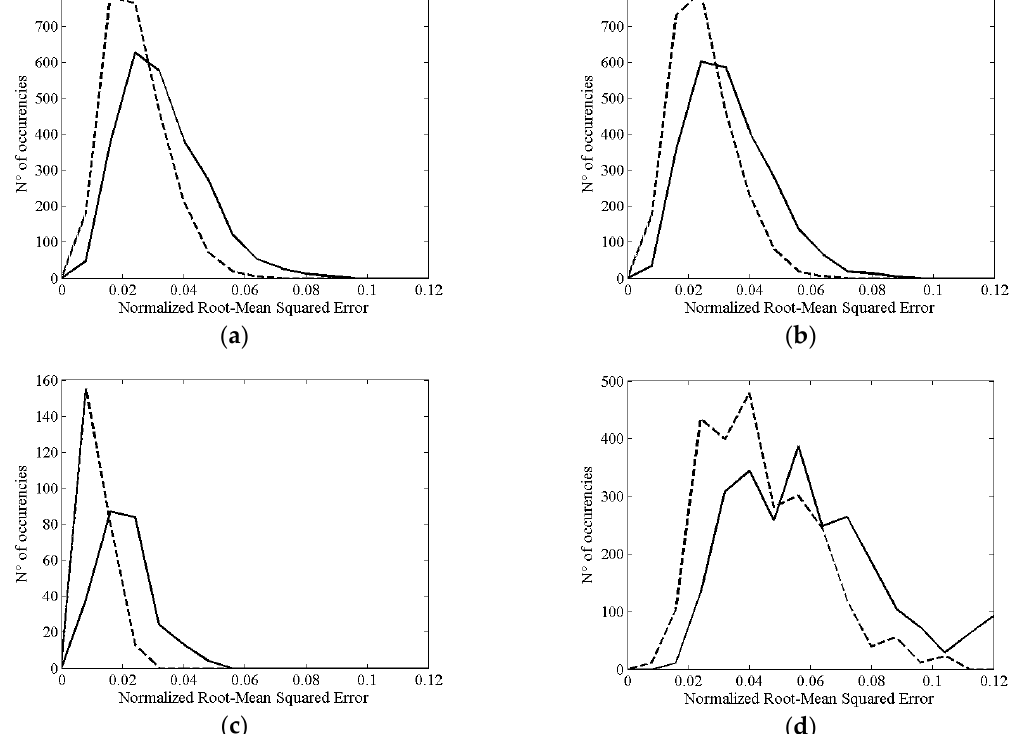
Figure 4. Distribution of Normalized Root Mean Squared Error between estimated and theoretical cross-correlation functions. Two curves are shown for each case: the difference with the weighted average approach (dotted line) and the difference with the simple average (solid line). ( a ) Equal distribution of missing data segments groups across subjects; ( b ) 40% group A, 40% group B, and 20% group E (see Table 1); ( c ) Results related to the GFP with maximum correlation coefficient equal to 0.7; 40% group A, 40% group B, and 20% group E; ( d ) Simulations with six subjects mimicking the missing data segments distribution observed in our study.